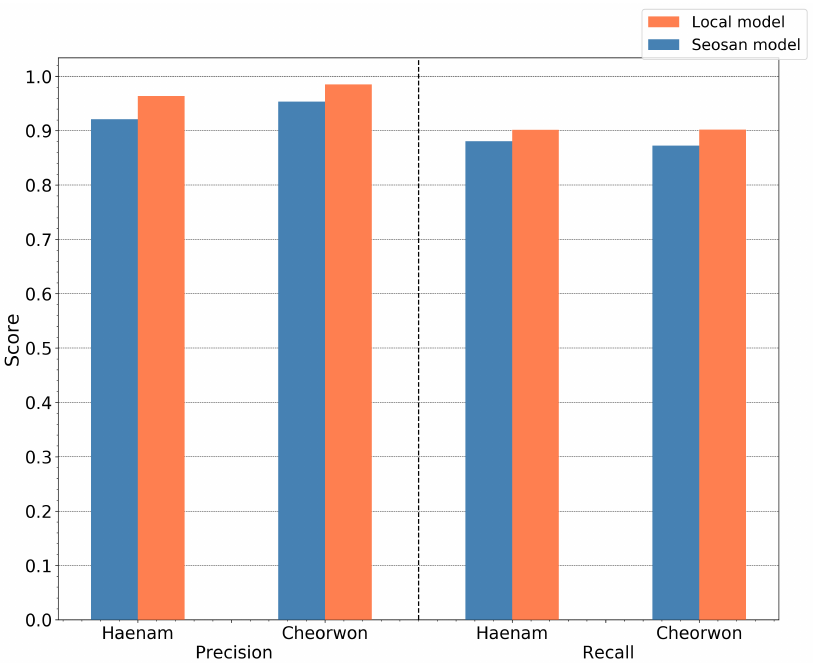
Figure 19. RF precision and recall for then Haenam and Cheorwon sites with predictions based on the (i) Seosan-Dangjin model and (ii) locally trained models.